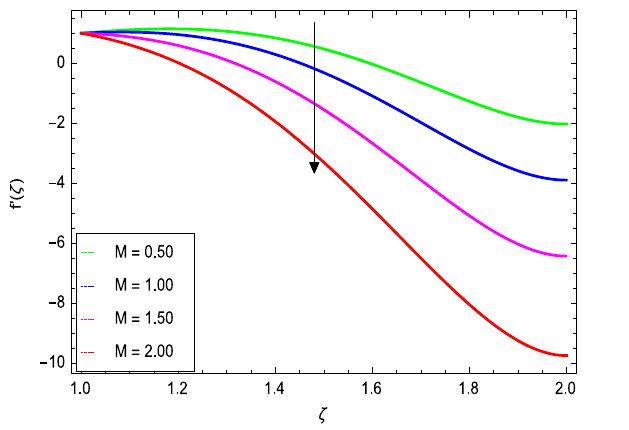
Figure 3. f ′ (ζ) as a function of M .